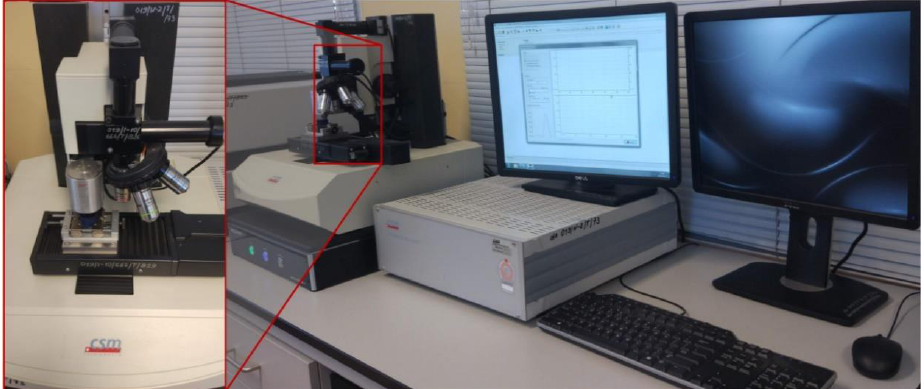
Figure 5. Nanoindentation test stand.